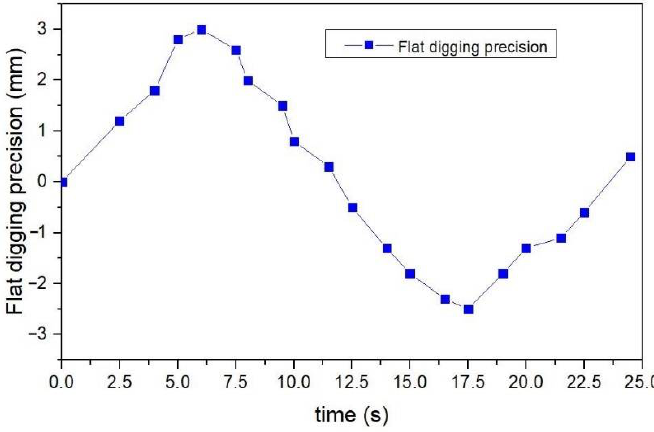
Figure 17. Flat digging precision diagram.